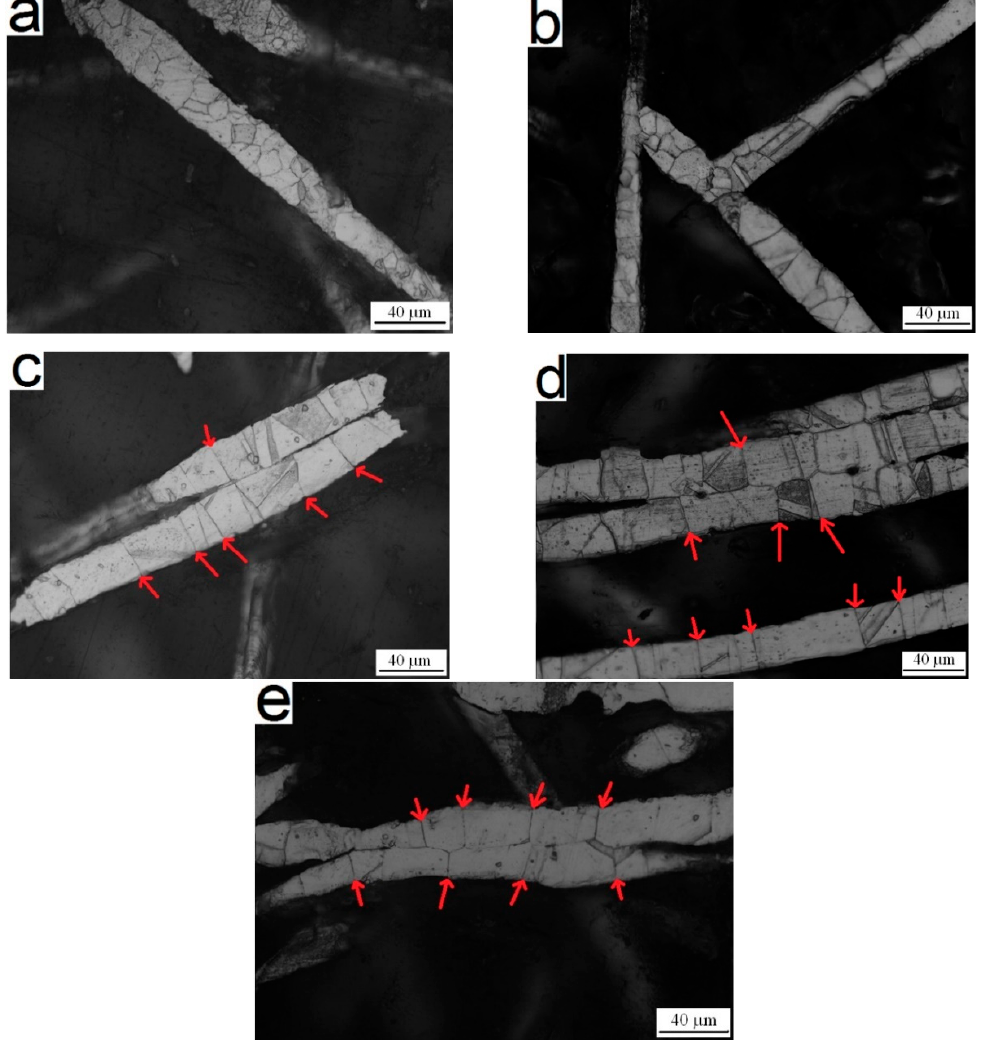
Figure 7. Optical micrographs of sample ( a ) I; ( b ) II; ( c ) III; ( d ) VI; ( e ) VII.